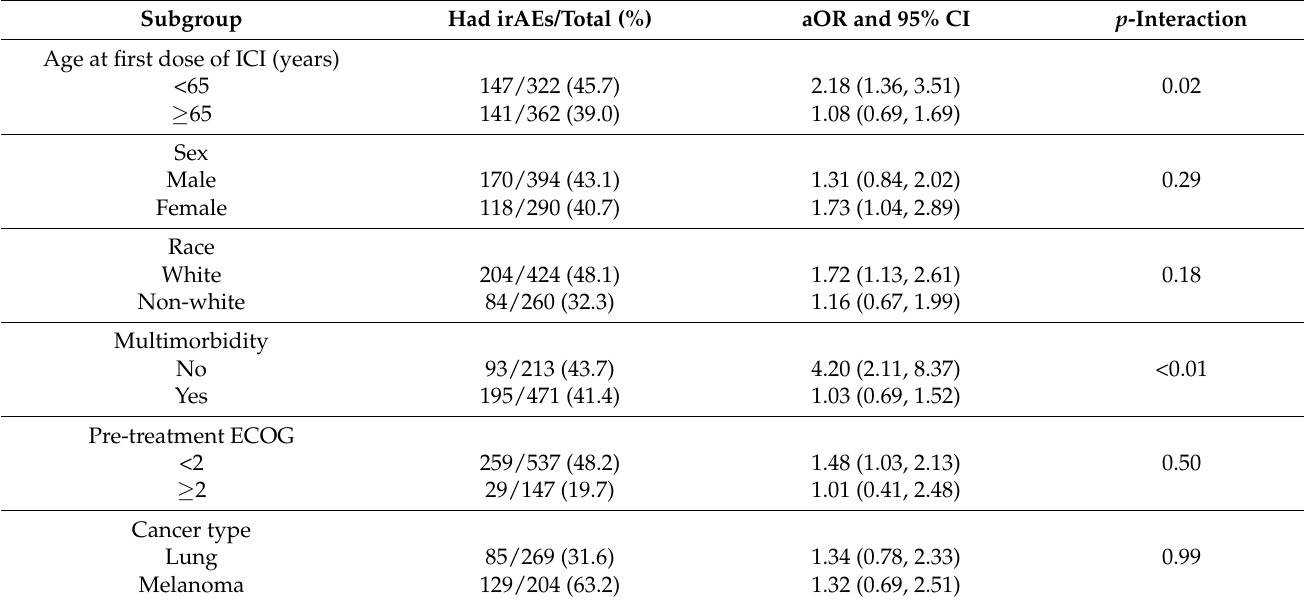
Table 3. Association of pre-treatment BMI (≥25 vs. <25 kg/m 2 ) with irAEs in subgroups. Subgroup